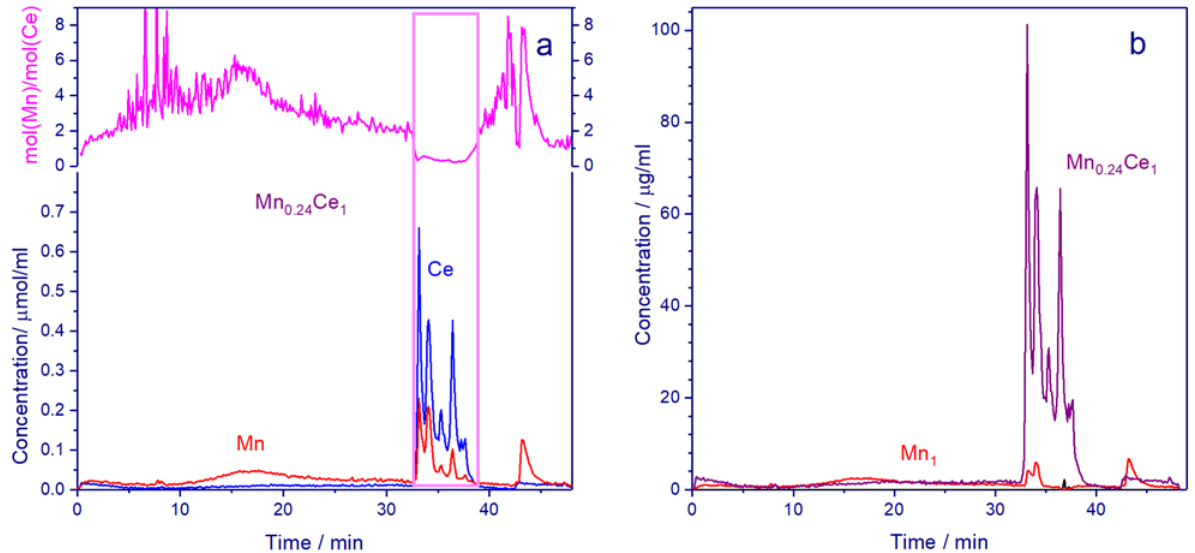
Figure 5. The dissolution curves for manganese and cerium, depending on time, the Mn/Ce ratio of the Mn0.45Ce0.55 catalyst ( a ). The dissolution curves for Mn 1 and Mn 0.24 Ce 1 phases ( b ).